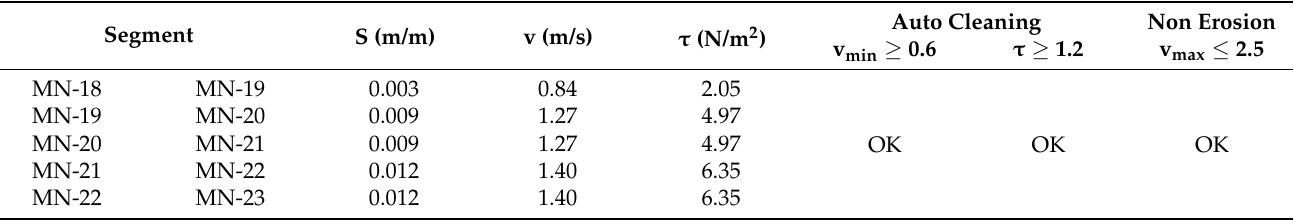
Table 14. Hydraulic parameters of the pipeline connecting to the sewerage system of